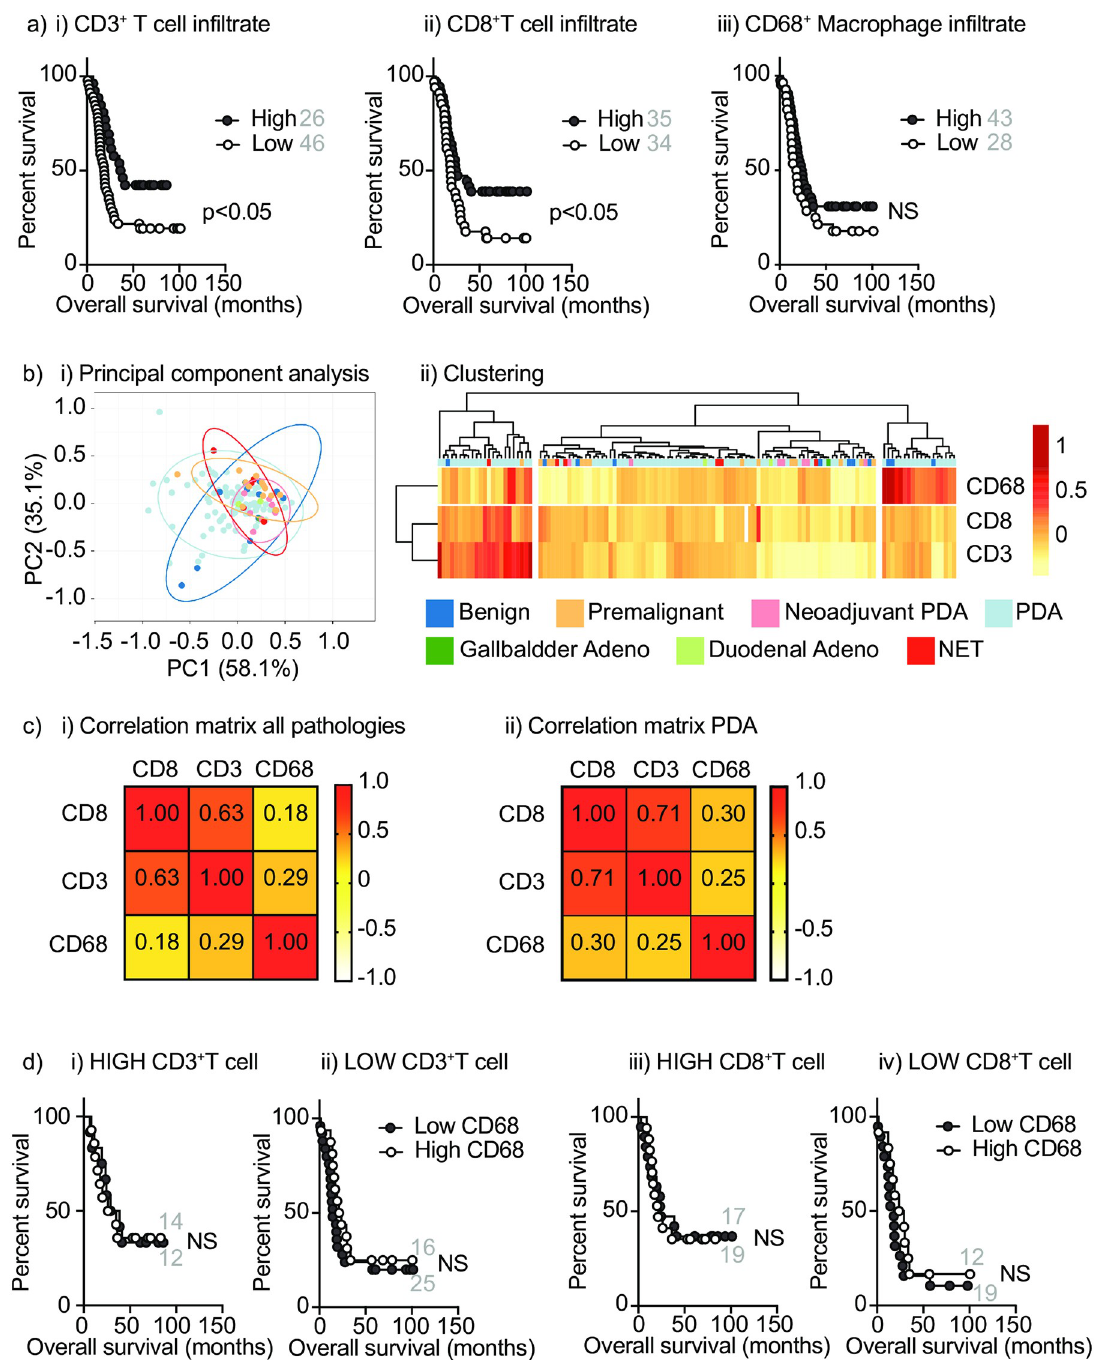
Fig 1. Analysis of patients by quantitative immunohistology. a) Quantitative analysis of infiltrating i) CD3 + ; ii) CD8 + ; and iii) CD68 + cells/mm 2 tumor were used to set cutoff values of high/low infiltrates with significant impact on overall survival of patients with PDA. Cutoffs used were approximately CD3 – 75 th percentile; CD8 –median; CD68 –no significant cutoff found, 75 th percentile shown. b) Infiltrating CD8 + , CD3 + , and CD68 + cells across a range of pathologies was used to evaluate principal component analysis and clustering. i) Unit variance scaling is applied to rows; SVD with imputation is used to calculate principal components. X and Y axis show principal component 1 and principal component 2 that explain 56.7% and 30.5% of the total variance, respectively. Prediction ellipses are such that with probability 0.95, a new observation from the same group will fall inside the ellipse. N = 123 data points. ii) Clustering of patients according to infiltrates. Imputation is used for missing value estimation. Both rows and columns are clustered using Manhattan distance and complete linkage. 3 rows, 123 columns. c) Pearson correlation coefficients for CD8, CD3 and CD68 infiltrating cells in i) all